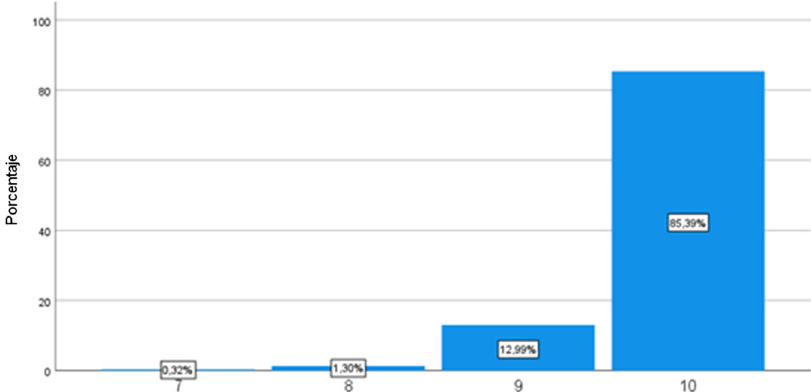
Fig. 2 Teaching quality on the master ’ s degree (materials, content, resources, methods, teaching practices) (%). From: Data obtained from question no.10 from que survey (closed, scaled, on a scale of 1: very bad to 10: excellent). Compiled by the authors through the SPSS.